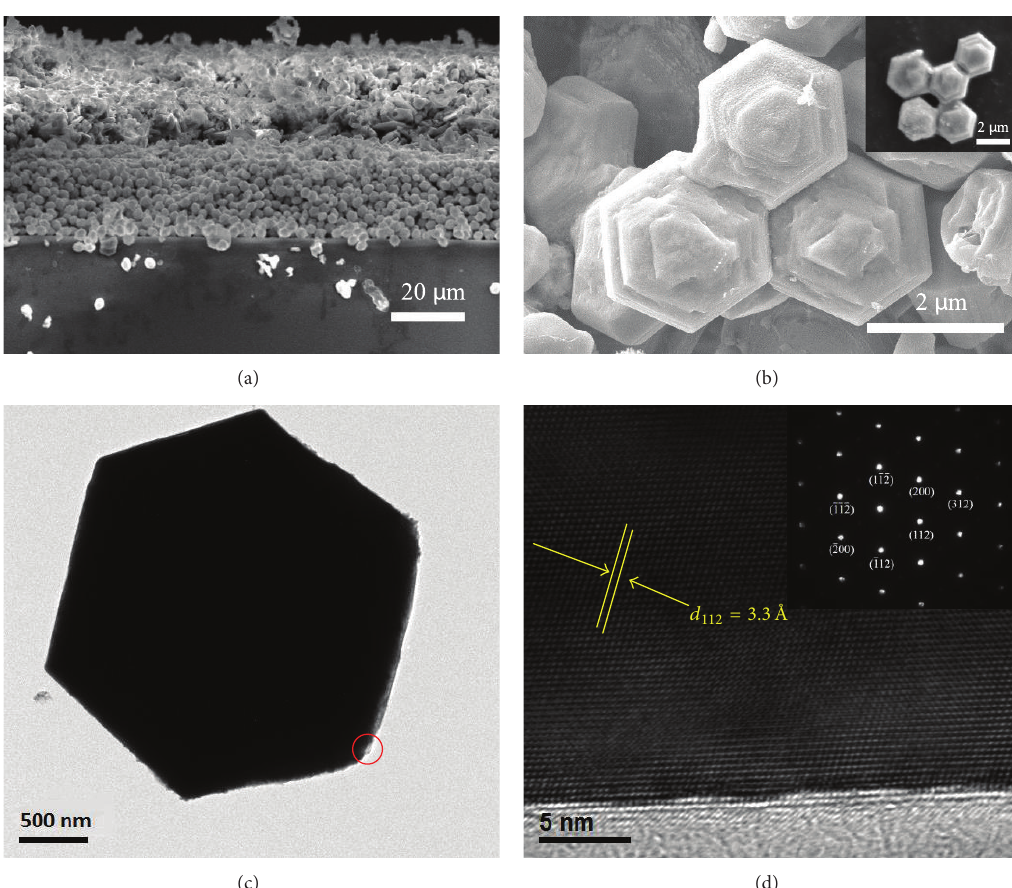
Figure 3: Various images of the as-prepared CIS thin film from path A: (a) cross-sectioned SEM image for the as-synthesized CIS before annealing and (b) that after annealing, (c) LR-TEM, and (d) HR-TEM and SAED (the insert) images for the as-prepared